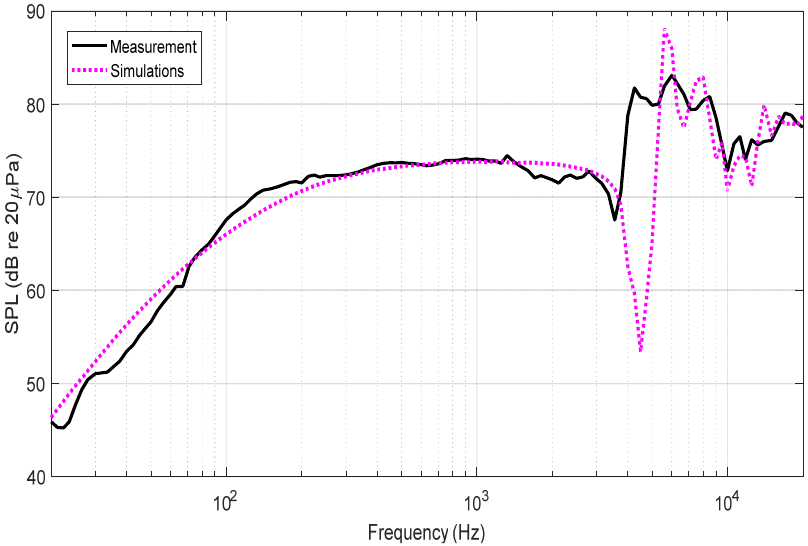
Figure 5. Simulated and measured of the frequency response curves of the microspeaker without ventilation cloth.